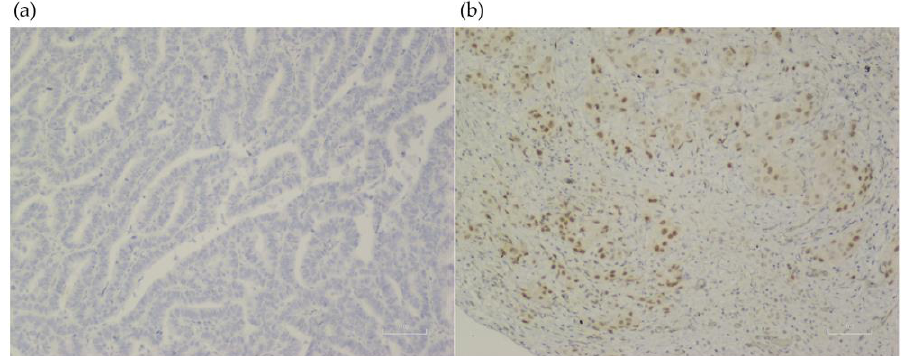
Figure 1. LKB1 expression assessment in lung tissue from samples of patients with lung